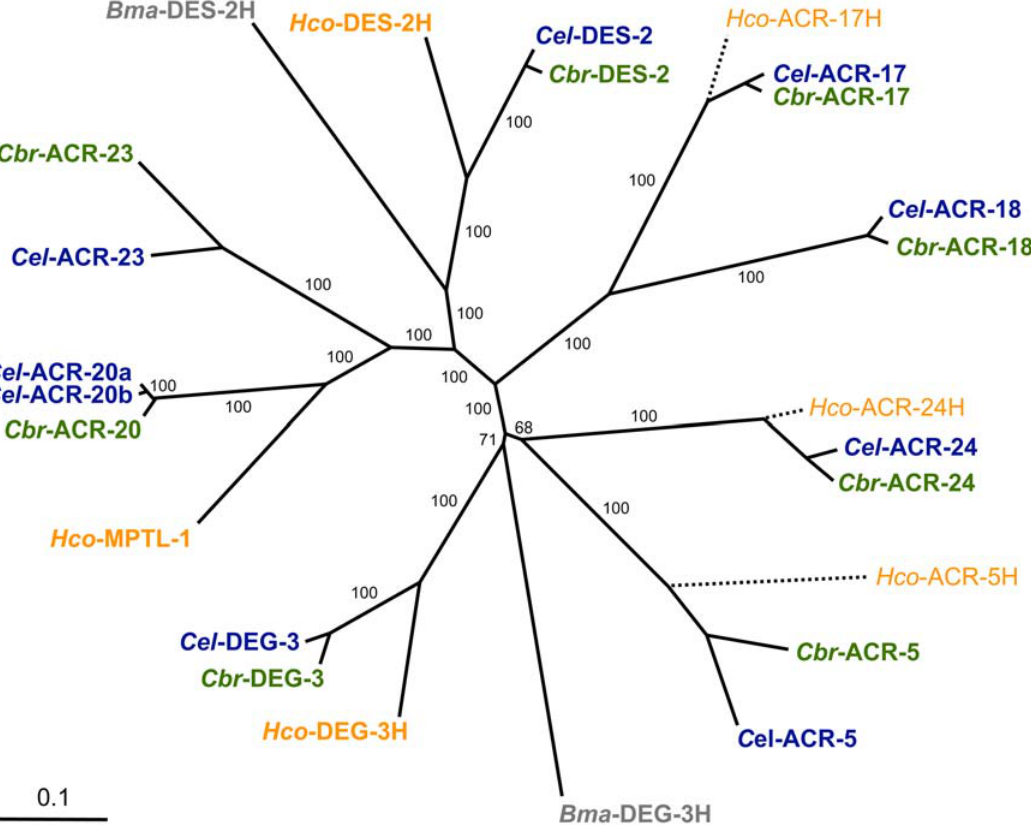
Figure 1. Phylogenetic analysis of the DEG-3 subfamily of nAChR. ClustalW dendrogram [49] of nAChRs subunits of the DEG-3 subfamily (amino acid sequences) from B. malayi ( Bma ; grey), C. briggsae ( Cbr ; green), C. elegans ( Cel ; blue), and H. contortus ( Hco ; orange). Two isoforms (a and b) of Cel -ACR-20 are shown. The scale bar indicates the number of amino acid substitutions per site, bootstrapping values are shown in percent positives of 1000 rounds. Tree construction and bootstrapping was initially performed on full-length sequences only; the partial sequences (dashed lines, thin characters) were added subsequently based on a second ClustalW guide tree.